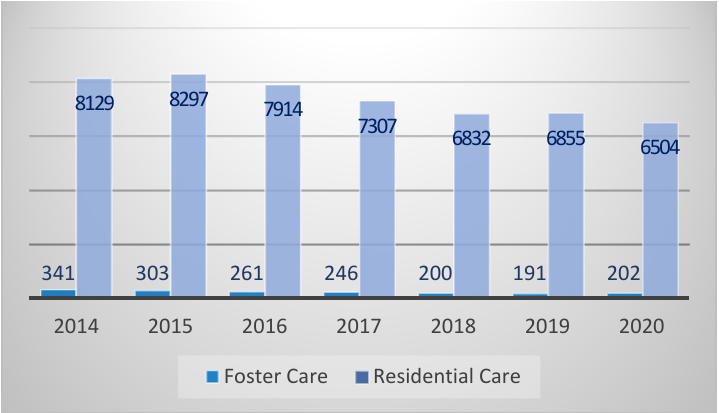
Figure 2. Number of children in alternative care in Portugal (2014–2020). Source: own elaboration based on CASA Report [34].